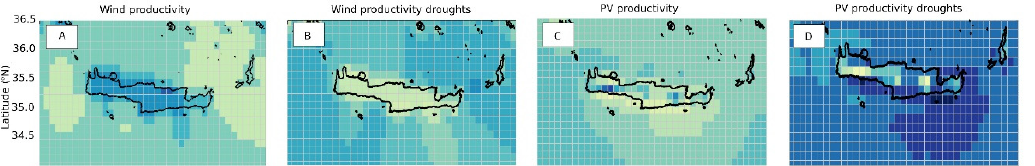
Figure 1. Ensemble mean wind productivity and frequency of wind productivity droughts (first and second columns), as well as ensemble mean photovoltaic (PV) productivity and PV productivity droughts (third and fourth columns) in the Balearic Islands ( A – D ), Corsica ( E – H ) and Sardinia ( I – L ) in the control time period (1986–2005). Wind productivity is given in kWh/kW times 10 3 , PV productivity in kWh/kW and the frequency of droughts in % of days within the 20-year period.